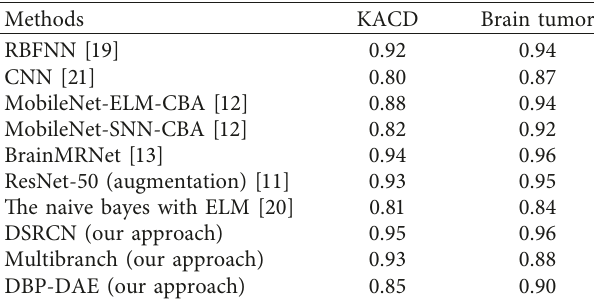
Table 5: Comparison of the proposed approach with state-of-the- art